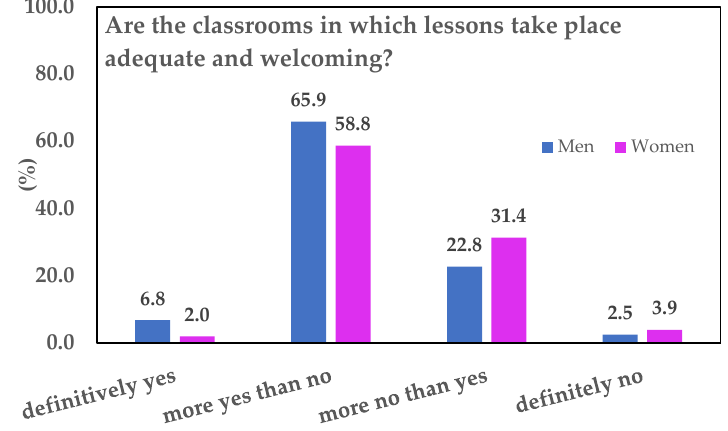
Figure 5. Adequacy and comfort of classrooms.